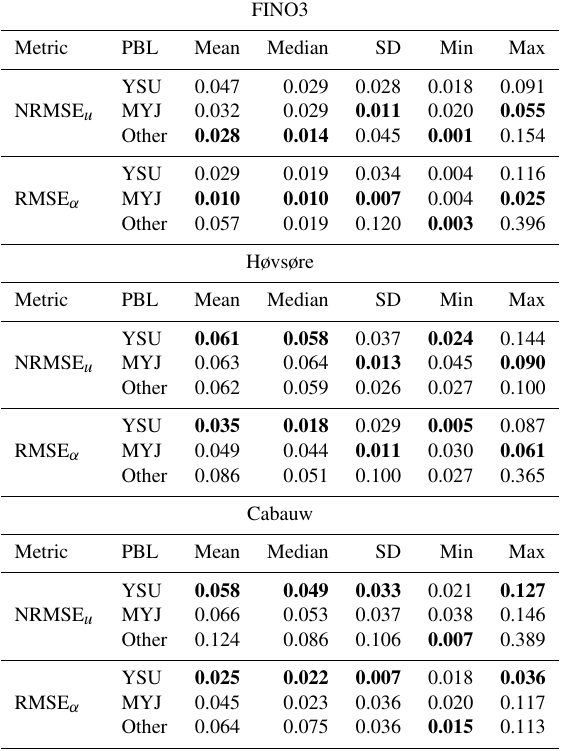
Table 6. Statistics of NRMSE for wind speed (NRMSE u ) and RMSE for wind speed shear exponent (RMSE α ) associated with the group model grid spacing across all heights at each site. There are seven models in the fine group, eight in the moderate group, and six in the coarse group. The smallest value for each metric is in